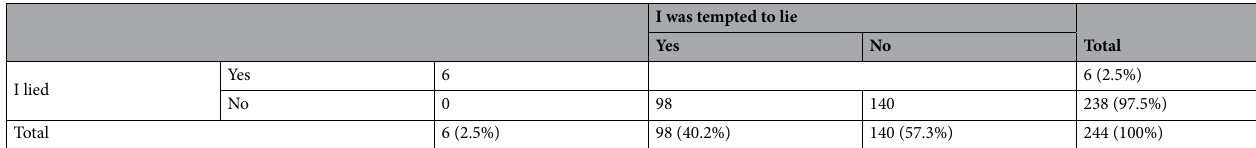
Table 6. Dishonesty in this survey. Crosstab of NSF Fellows tempted to lie and confessed to actually lying on this